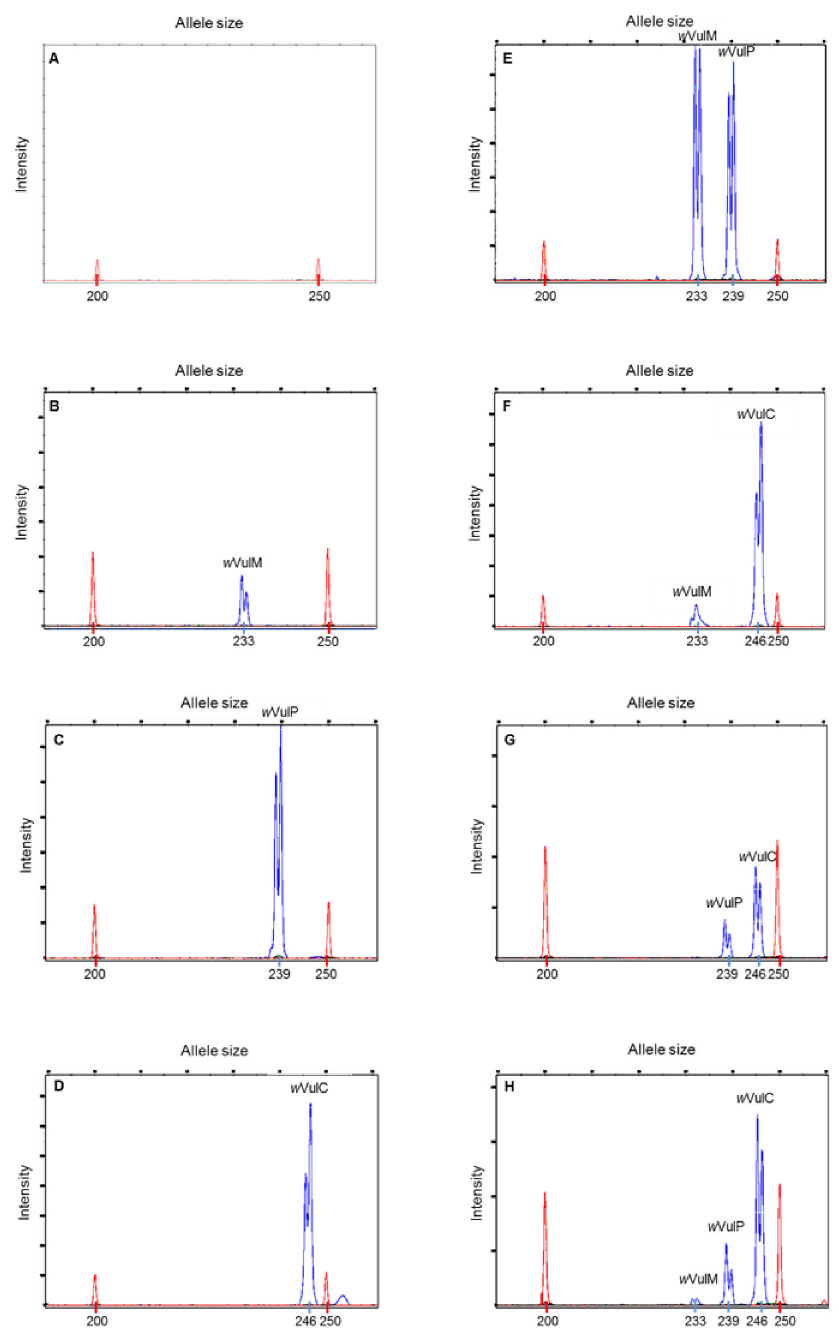
Figure 1. Chromatograms obtained from experimental injections of the different Wolbachia strains. Chromatograms are obtained respectively when inoculate was made up of: A) no Wolbachia strain; B) w VulM strain; C) w VulP strain; D) w VulC strain; E) w VulM and w VulP strains; F) w VulM and w VulC strains; G) w VulP and w VulC strains; H) w VulM, w VulP and w VulC strains. Size markers appear in red. Wolbachia appear in blue. The fragment sizes for w VulM, w VulP and w VulC are 233, 239 and 246 bp